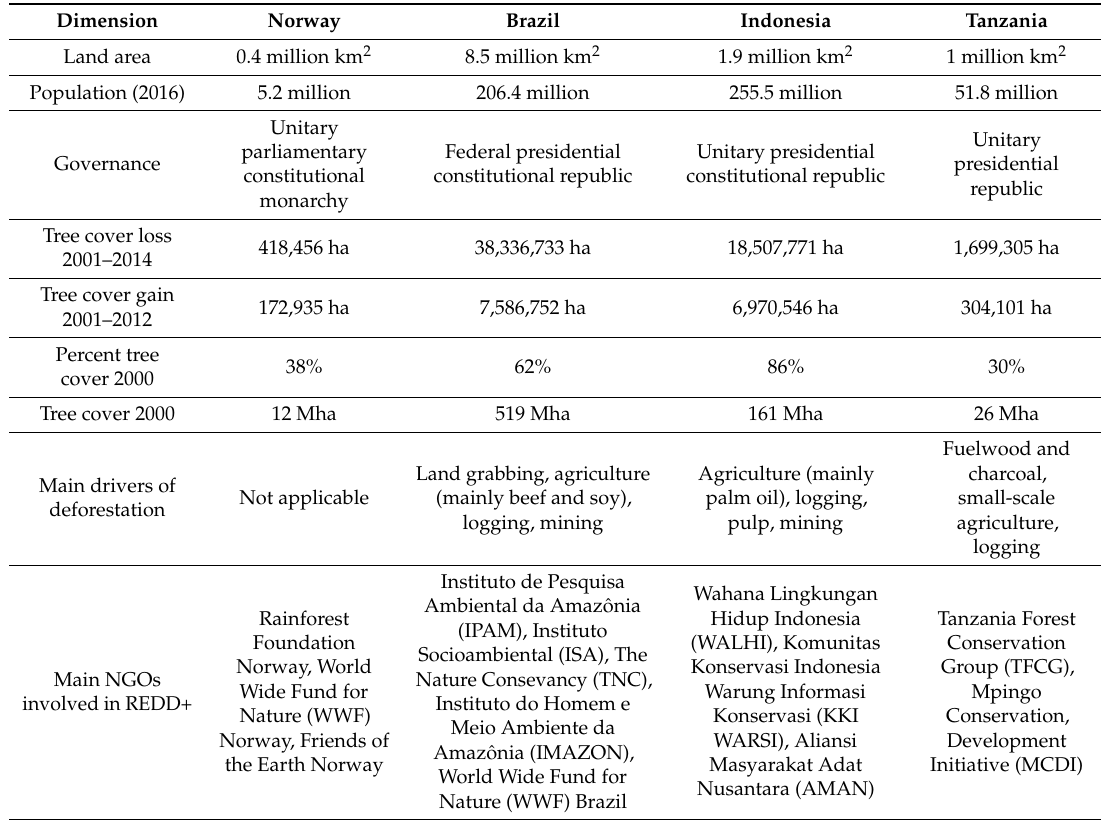
Table 1. A comparison of Norway, Brazil, Indonesia, and Tanzania across key dimensions related to Reducing Emissions from Deforestation and Forest Degradation (REDD+) and Norway’s International Climate and Forest Initiative (NICFI). Forest data from Global Forest Watch. Data on land area, population and governance from